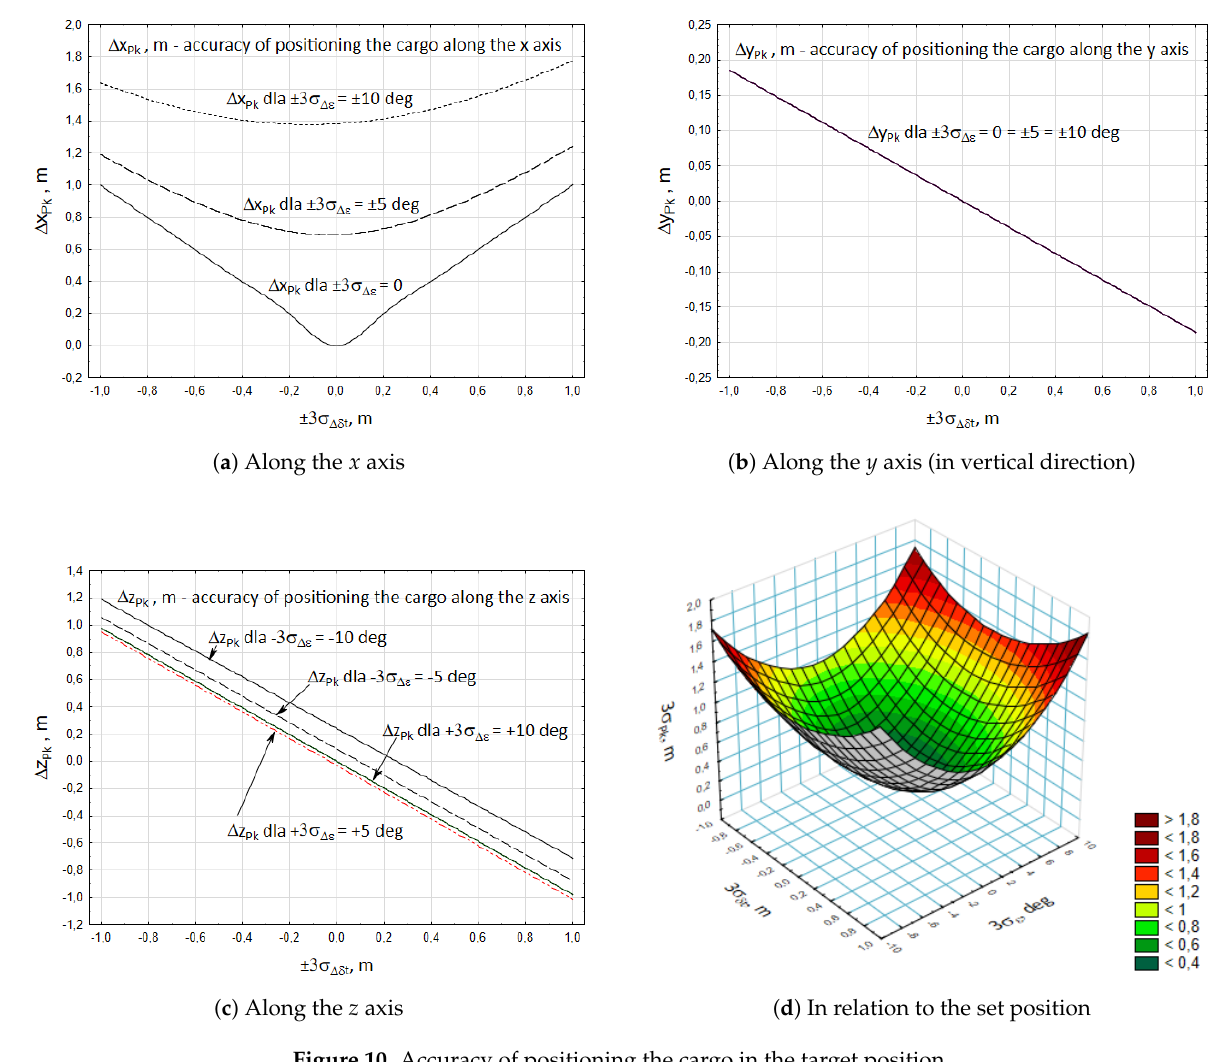
Figure 10. Accuracy of positioning the cargo in the target position. Table 2. Sequences of the crane’s working movements, for two cases of the realized cargo handling task during initial